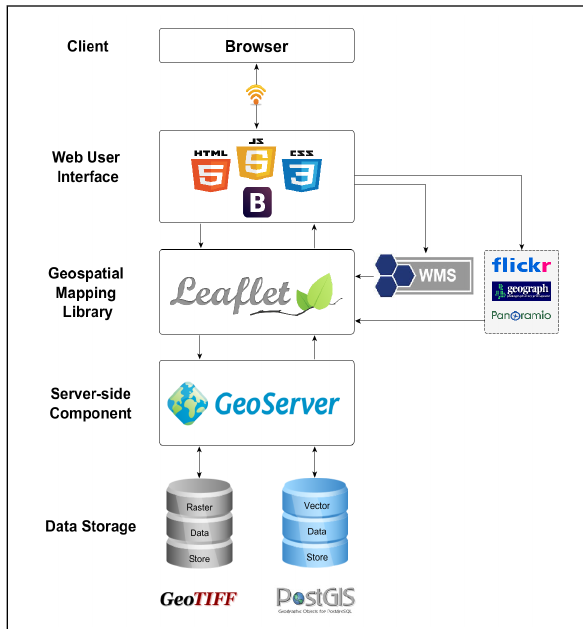
Figure 1. EU-LULC WebGIS architecture